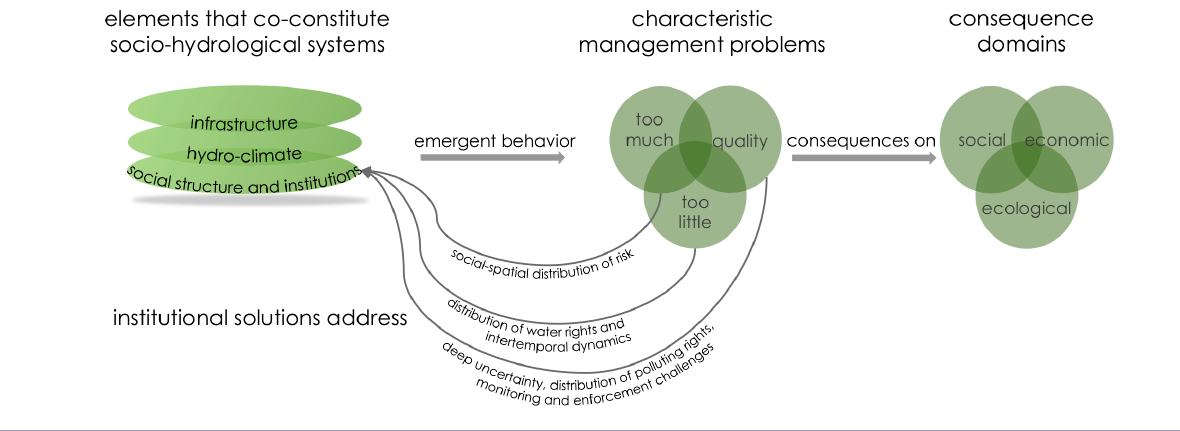
Fig. 1. Water systems are a distinct class of coupled systems because they present a finite set of recurrent management challenges: disturbances of too much, too little, or wrong-quality water. These challenges can manifest alone or in combination at different temporal and spatial scales and have differential impacts within and across social groups. Thus, water systems provide us with a long historical record of institutional innovation in response to management challenges at increasingly large scales of social organization, from small farming settlements to nation